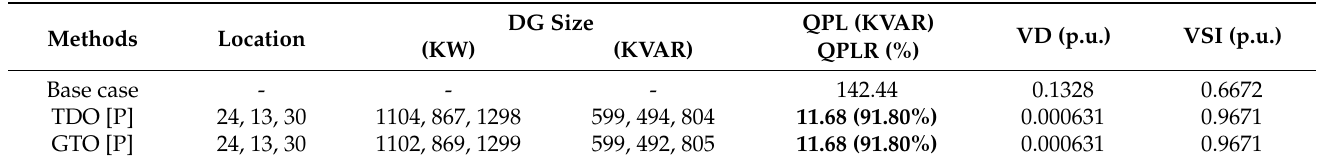
Table A2. Results of OADG for a 33-bus RDN for SOF (QPL minimization) at 0.85 pf (WT type) in a CP load model.